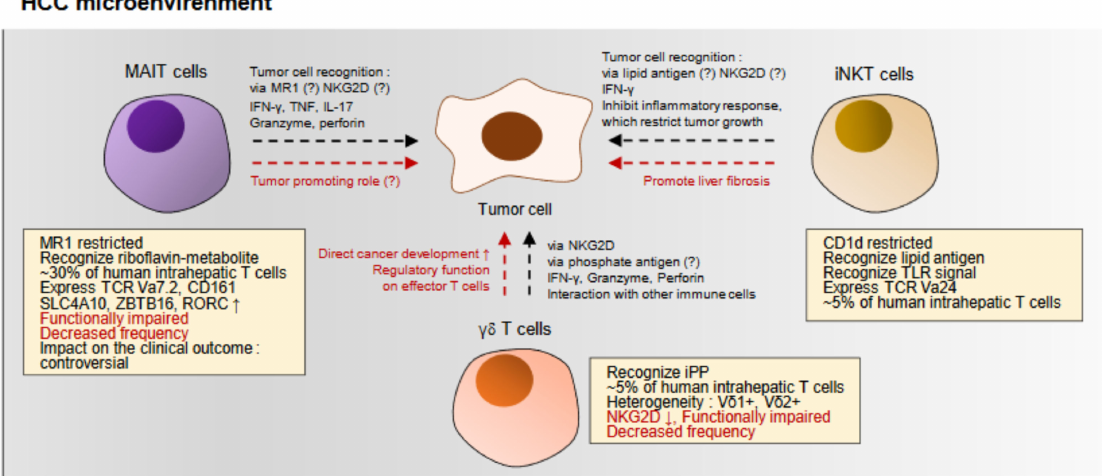
Figure 3. Unconventional, innate-like T cells in HCC. Unconventional T cells such as mucosal associated invariant T (MAIT) cells, γδ T cells, and invariant natural killer T (iNKT) cells consist ≈ 40% of liver resident T cells. However, their role in the anti-tumor immunity in HCC needs to be elucidated in future studies. MAIT cells are a major population of intrahepatic and HCC-infiltrating lymphocytes. Although the tumor recognition mechanism is unclear, they secrete cytokines and perform cytotoxicity against tumor cells. They are functionally impaired and reduced in the HCC. Impact on the patient survival of the MAIT cells is a controversial issue, because two previous studies reported different results. The tumor-promoting role of the MAIT cells is unclear. γδ T cells also exist in the HCC, although their frequency is decreased and they are functionally impaired. There are reports that γδ T cells have a tumor-killing effect via cytokines and cytotoxic activity or interaction with other immune cell population such as B cells, natural kilter (NK) cells, or conventional T cells. On the other hand, there are also previous reports that suggested the tumor promoting role of these cells. This might be due to the heterogeneity of γδ T cells. iNKT cells also have anti-tumor role via cytokine secretion or inhibiting oncogenic, inflammatory signals in the liver. However, they also can promote liver fibrosis. Therefore, the role of unconventional, innate-like T cells in HCC needs to be investigated in future studies. Each arrow indicate that the one before the arrow affects the one after it. Question mark represents the hypothesis which is